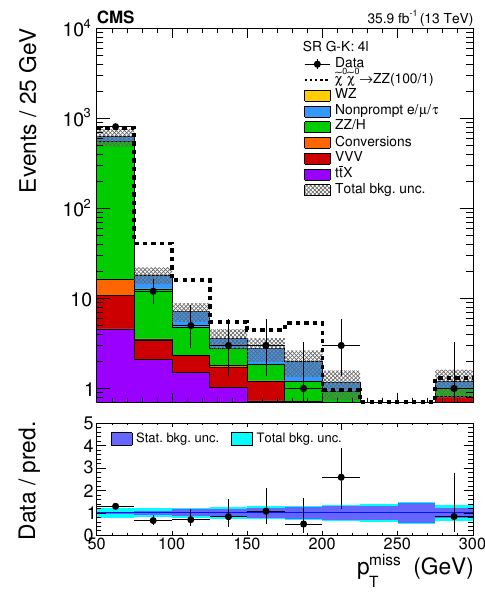
Figure 7 . Distribution in p miss for events with 4 or more leptons entering search categories T